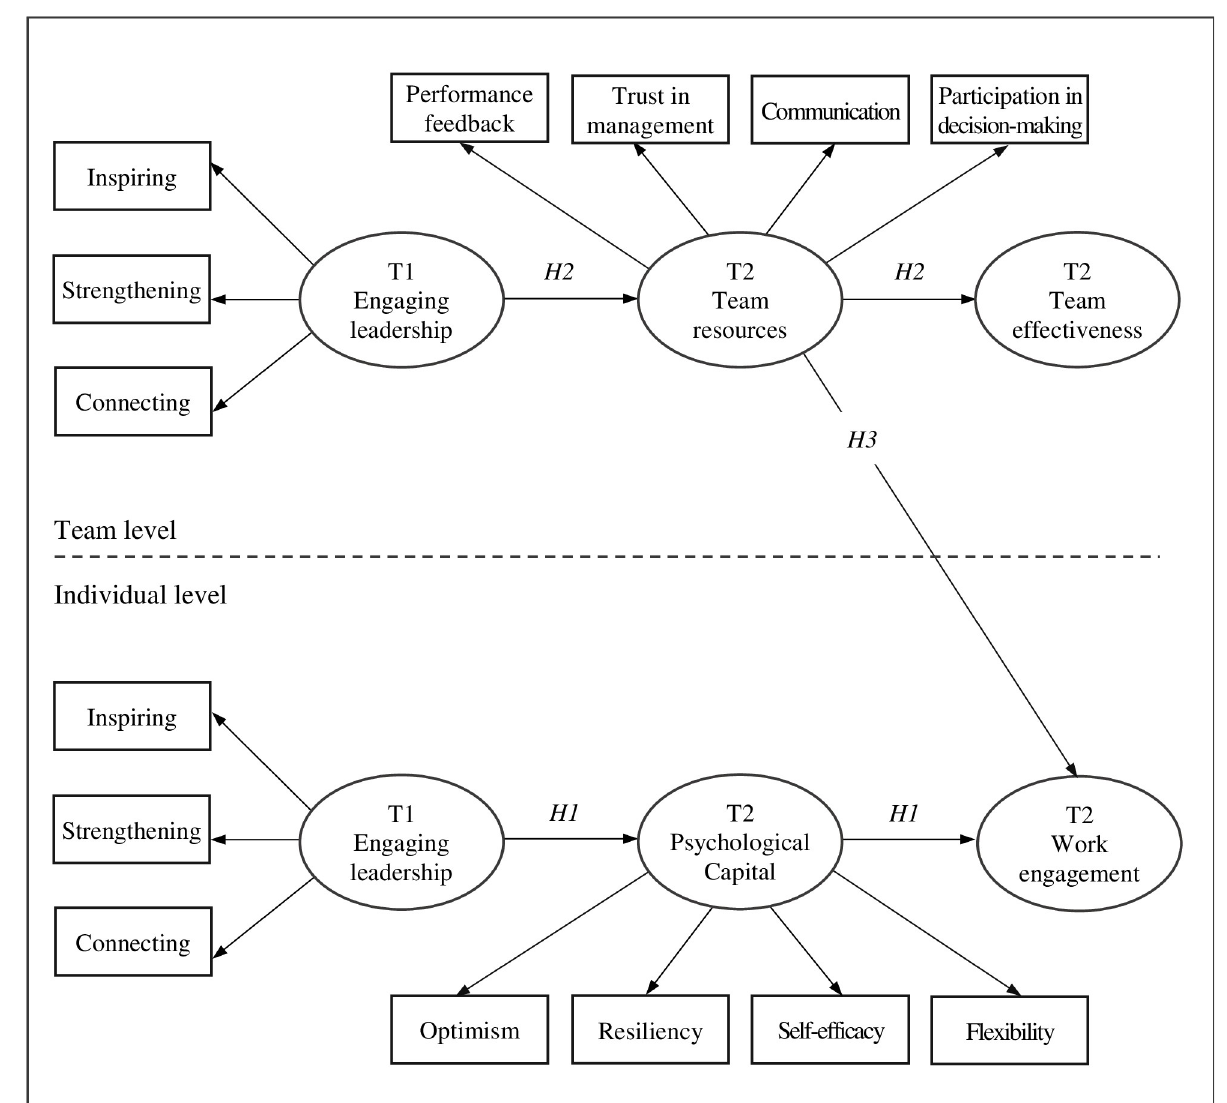
Fig 1. The hypothesized multilevel model of engaging